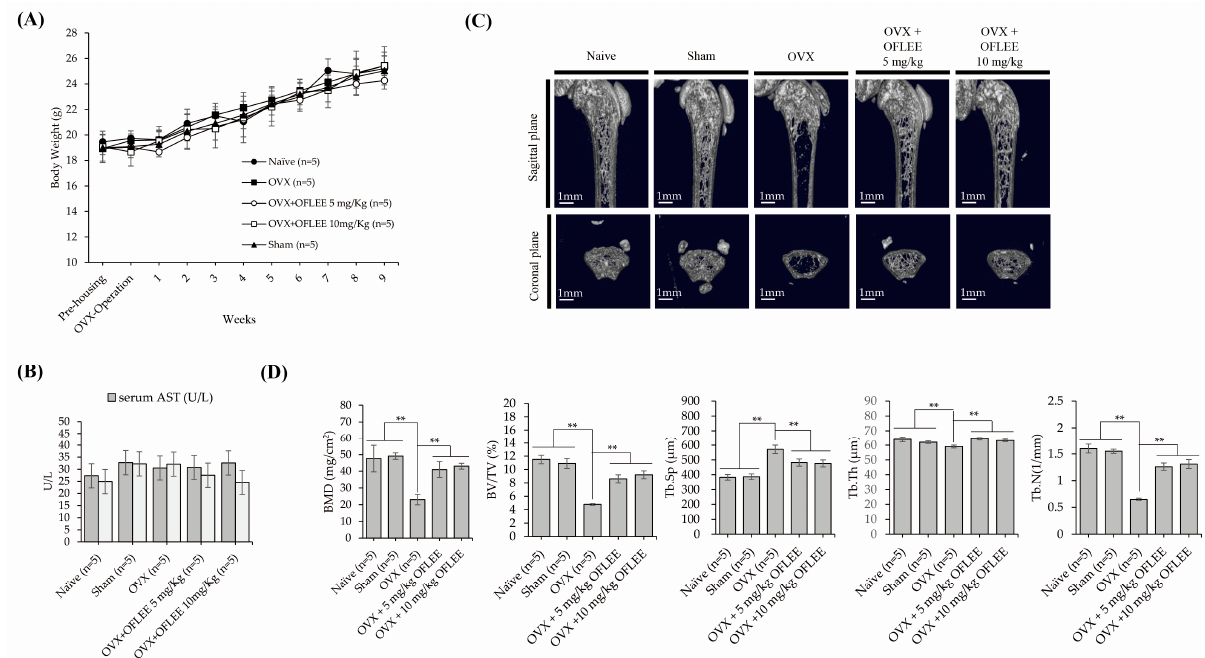
Figure 7. The oral supplementation of OFLEE prevented osteoclastic bone loss without hepatotoxicity in the experimental animals with OP generated by OVX. Animals (female C57BL/6 mice, 8-week-old) were randomly divided into 5 groups ( n = 5/group) as naïve, sham, OVX, OVX supplemented 5 mg/kg, and OVX supplemented 10 mg/kg. In addition, animals were surgically ovariectomized to generate the animal model with OP. Thereafter, experimental animals were supplied a vehicle (water 100 µ L), 100 µ L of 5 or 10 mg/kg OFLEE suspended in water by oral gavage once daily for 9 weeks. Body weights of experimental animals were measured by every week for 9 weeks. To verify the hepatotoxicity, ALT and AST were measured by mouse ALT ELISA kit and AST activity assay kit, respectively, in serum collected from experimental animals. The microarchitecture of the femur dissected from experimental animals was analyzed using the Quantume GX microCT imaging system. ( A ) Body weight of experimental animals had no statistical significance between all of the animal groups, during the experiment periods. ( B ) the concentration of ALT and AST in the sera collected from experimental animals had no statistical significance between all of the animal groups. ( C ) the oral supplementation of 5 mg/kg ( n = 5) or 10 mg/kg ( n = 5) OFLEE significantly suppressed the bone loss in the femoral bone of animals with OVX. ( D ) Trabecular morphometric parameters, such as bone mineral density (BMD), bone volume per tissue volume (BV/TV), trabecular number (Tb.N) and trabecular thickness (Tb.Th), were significantly decreased in the OVX group compared with naive, shame, OVX orally supplemented with 5 mg/kg or 10 mg/kg OFLEE groups, whereas trabecular separation (Tb.Sp) was increased in the OVX groups, compared with naïve, sham, OVX orally supplemented with 5 mg/kg or 10 mg/kg OFLEE groups. Results are mean ± SD of three independent experiments ( n = 3), ** p <